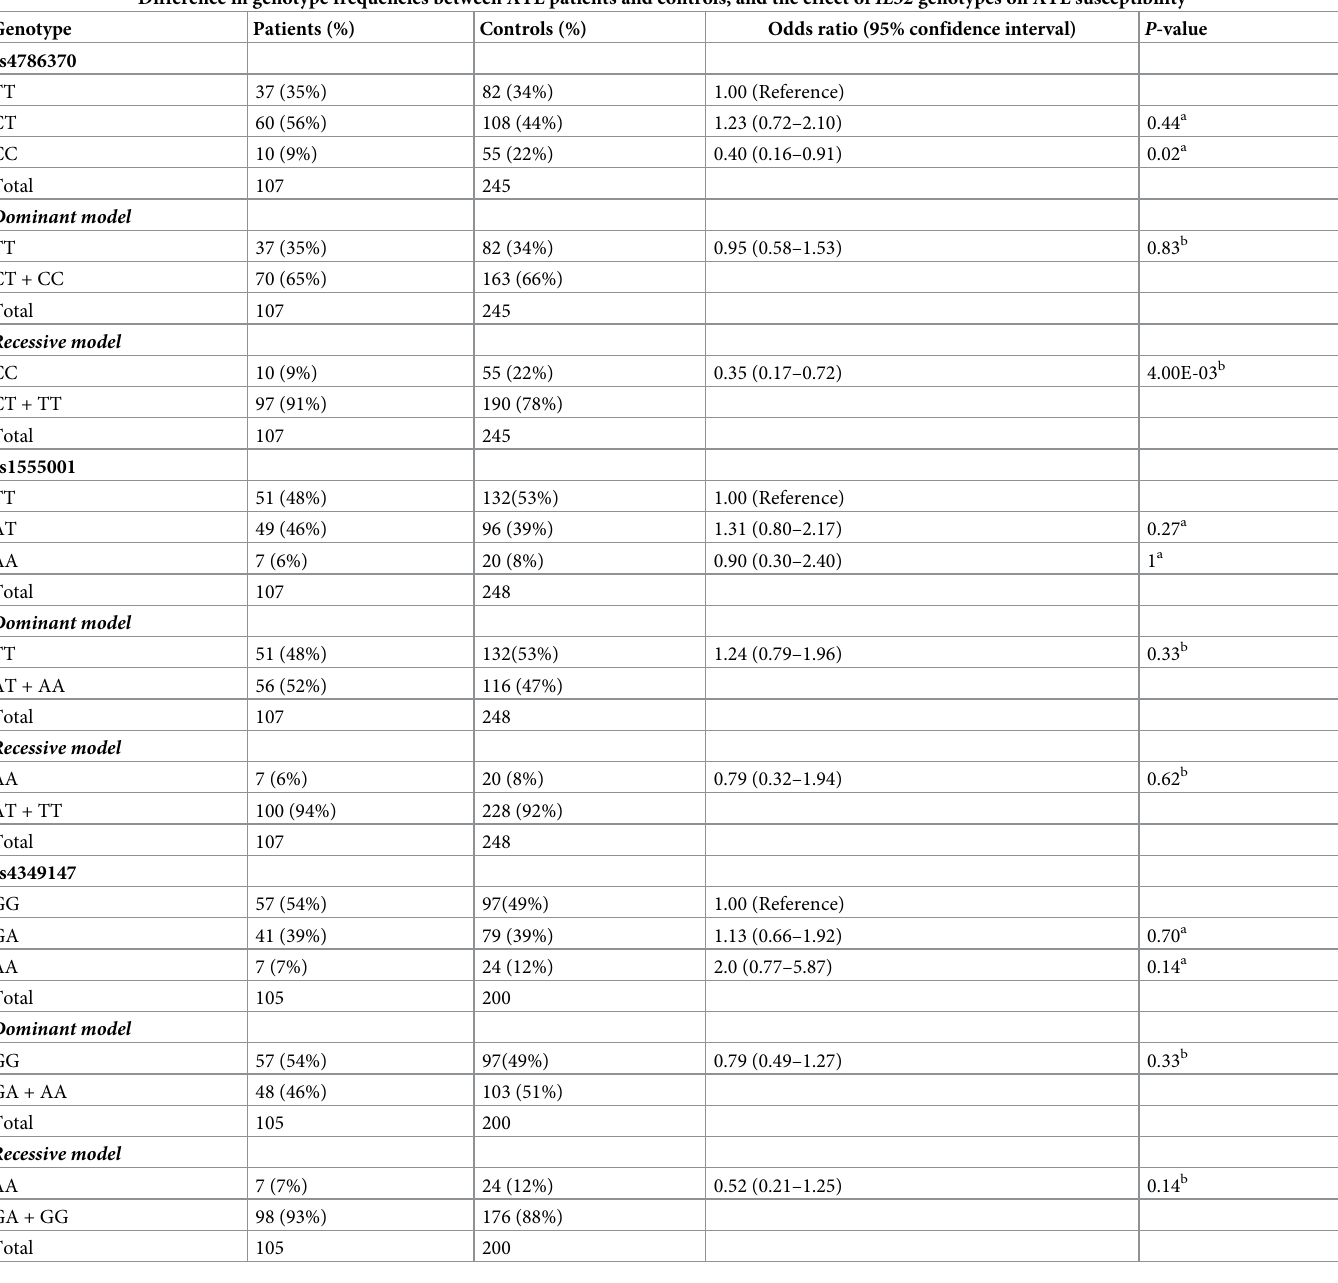
Difference in genotype frequencies between ATL patients and controls, and the effect of IL32 genotypes on ATL susceptibility